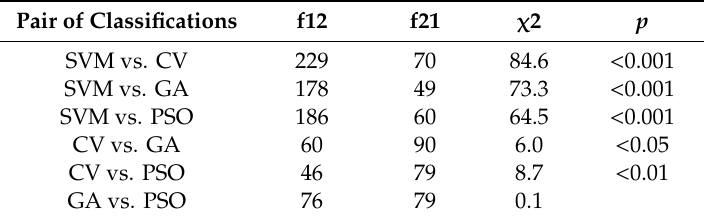
pond (99.00%), red roof (96.94%), and blue roof (98.49%); PSO provided the highest F1-measure values for paddy (88.78%), dark road (90.38%), light gray road (86.70%), open pit (52.41%), and ore processing site (54.14%). Moreover, CV and PSO were more e ff ective in discriminating pond and stream, with the highest F1-measure value of